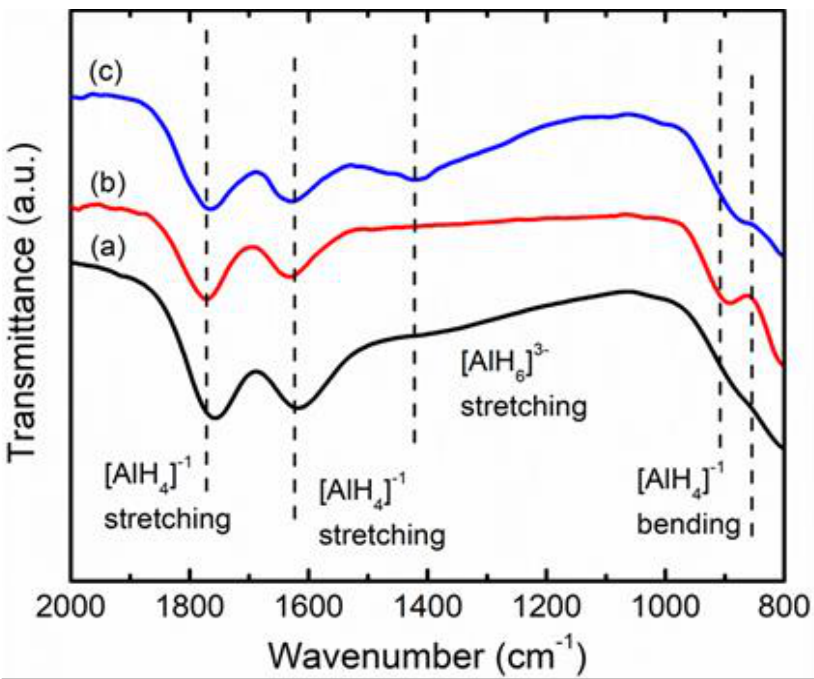
Figure 7. FTIR pattern of the ( a ) as-obtained LiAlH 4 , ( b ) post-milled LiAlH 4 , and ( c ) LiAlH 4 added with 10 wt% of TiSiO 4 . with 10 wt% of TiSiO 4